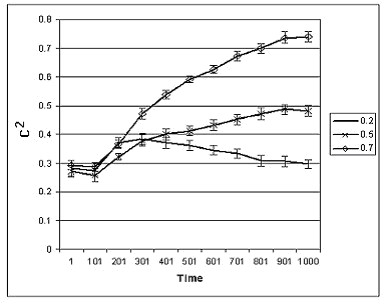
The evolution of the proportion of cooperating agents. The graphs show the mean (± SD) values of c2 (the proportion of agents participating in cooperation-cooperation interactions, where c is the proportion of cooperating agents in the population) in environments with various levels of uncertainty (see the numbers in the box).